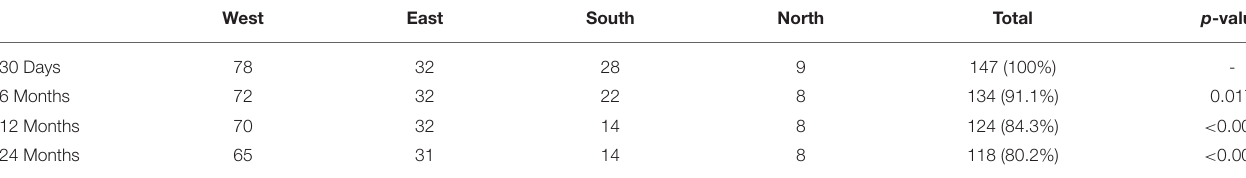
TABLE 9 | Geographical distribution and vessel